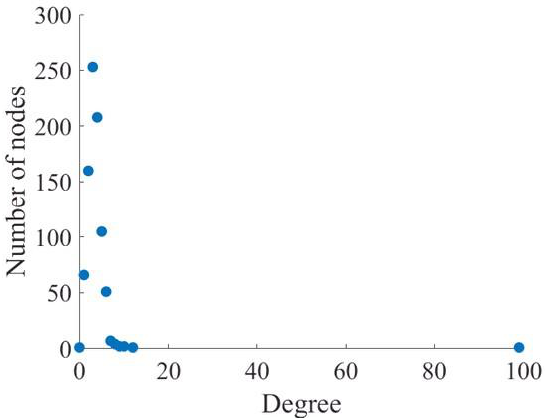
Figure 7. Degree distribution.